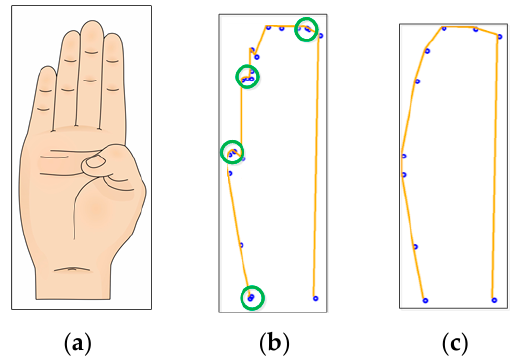
Figure 10. Size selection: ( a ) “B” ASL alphabet sign; ( b ) image processing result with 20 characteristic pixels; ( c ) image processing result with 10 characteristic pixels. pixels; ( c ) image processing result with 10 characteristic pixels.